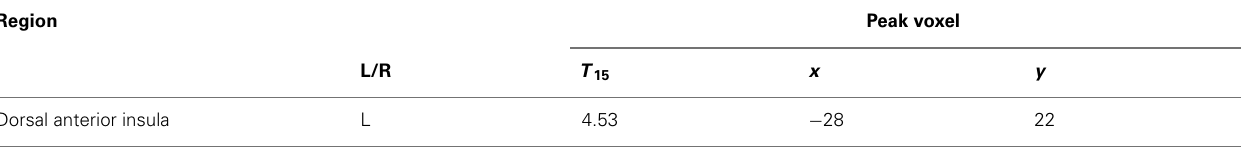
Table 3 | Correlation between activation based on choice (risky–safe) and SPIN score. Region